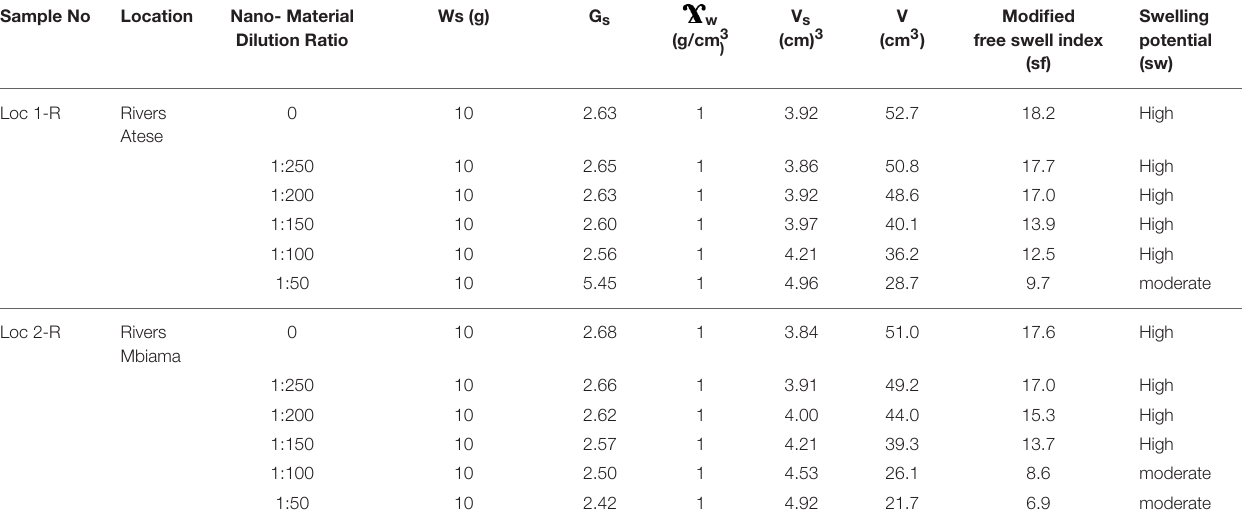
TABLE 9B | Summary of 24h free swell test for two sample locations. Sample No Location